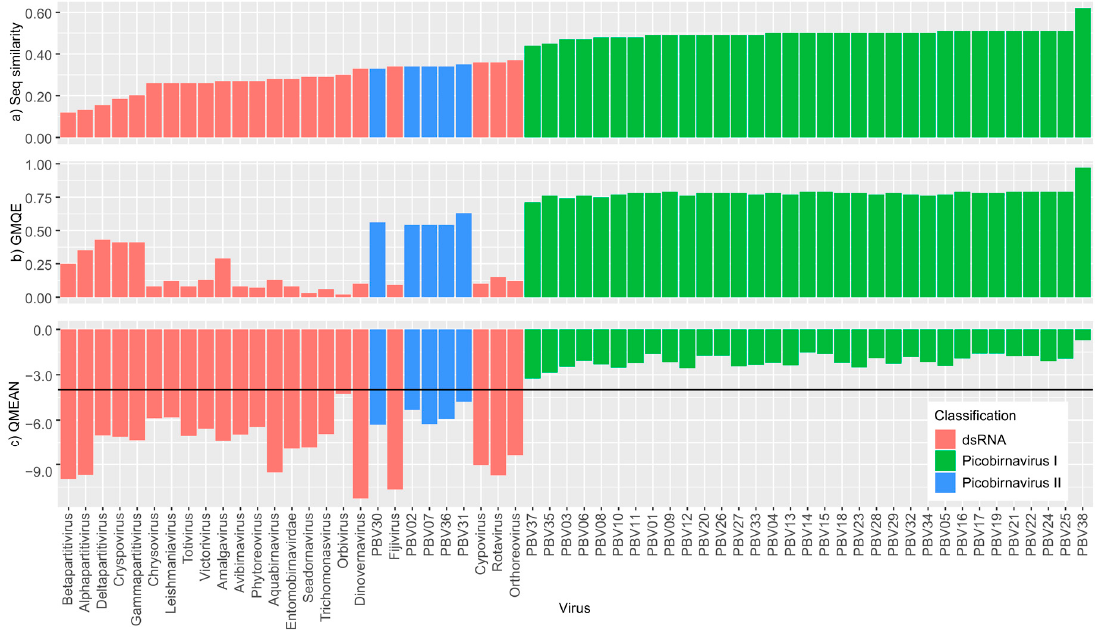
Figure 3. Swiss Model results ( a ) sequence similarity to template, ( b ) Global Model Quality Estimate (GMQE) and ( c ) QMEAN for all sequences. Higher QMEAN scores indicate a better match to the template and the horizontal line in the QMEAN graph at − 4 indicates the model quality cut off point.